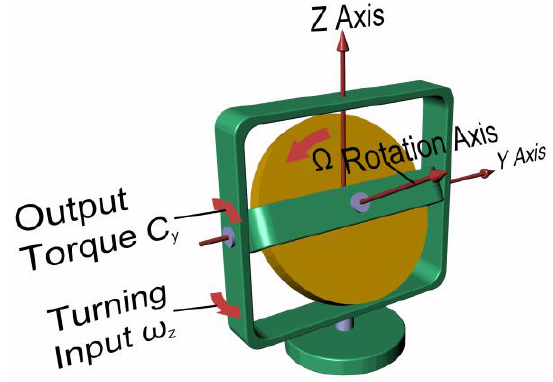
Figure 2. Elements of a mechanical gyroscope and main Figure 2 . Elements of a mechanical gyroscope and main parameters.